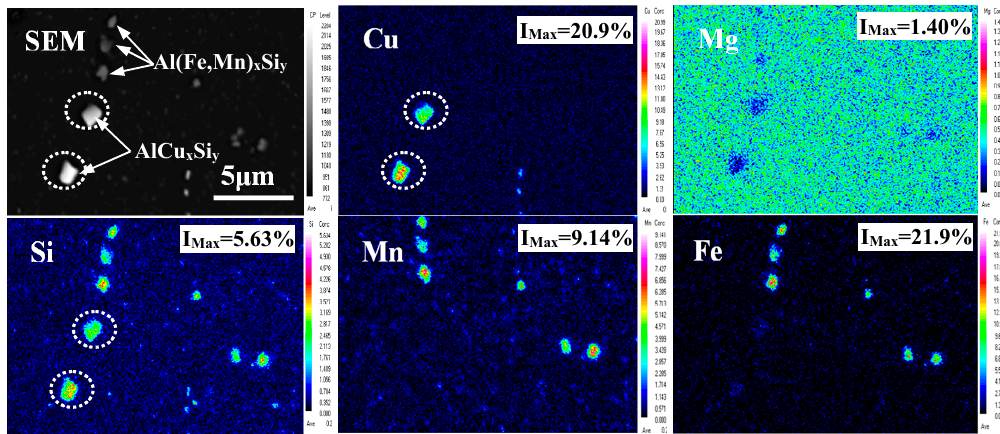
Figure 6. Elemental mapping of the as-quenched Alloy 1 examined by EPMA.